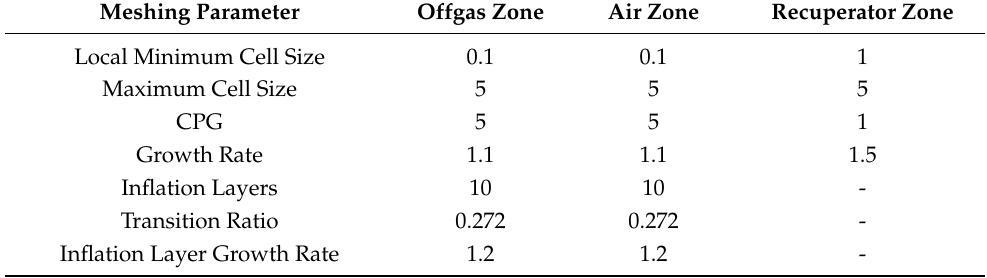
Table 1. Meshing parameters for the surface mesh used for the detailed simulation.